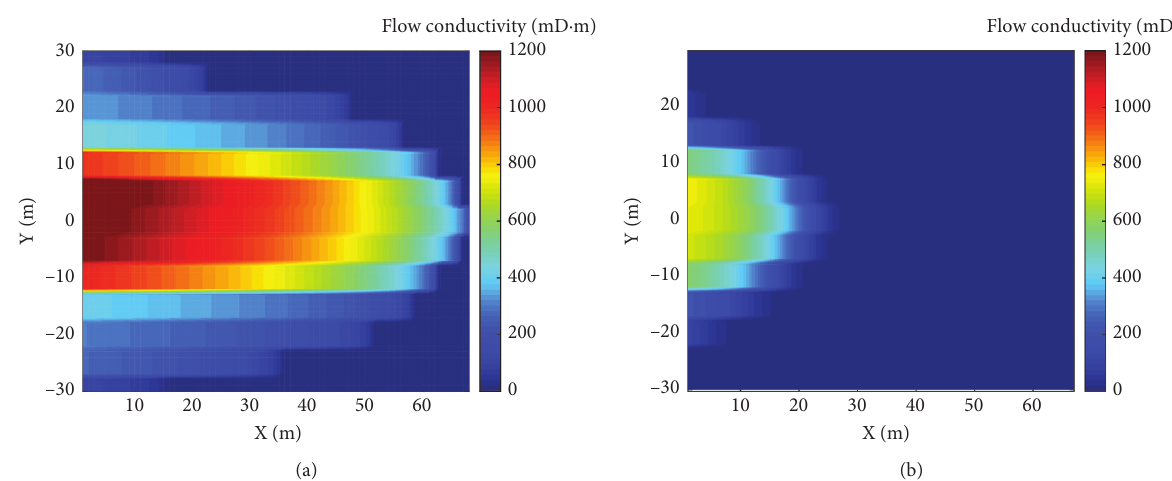
Figure 1: Pulverized coal plugging and fracture closure lead to failure of conductivity (the right figure